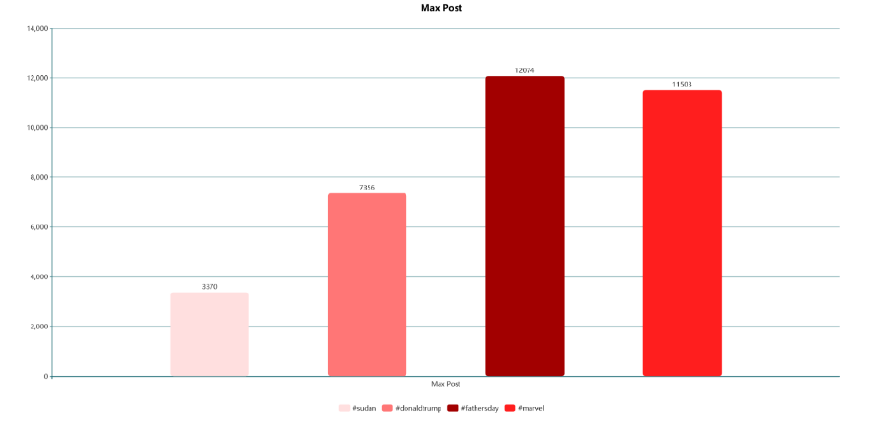
Figure 7 visualization of the hashtag comparison view on x-z plane